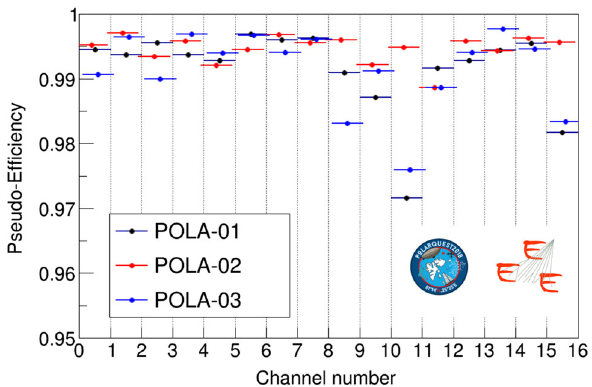
Fig. 12 Channel by channel PE averaged in the full period, for POLA- 01,POLA-02andPOLA-03.Here,thebinomialerrorsareused,tosmall to be visible